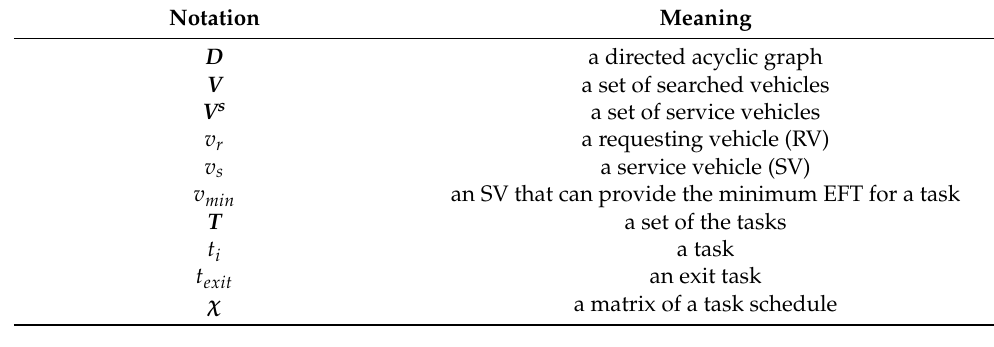
Algorithm 1: VAO in a RV v